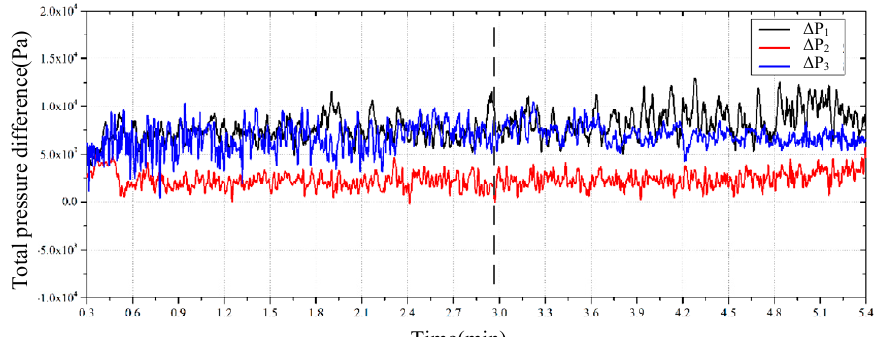
Figure 16. Variations in the total pressure difference (case 3).